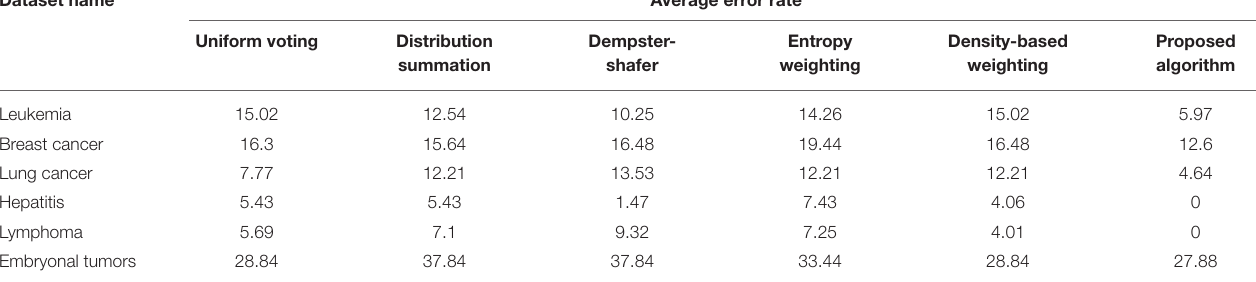
TABLE 2 | Performance on the UCI data sets (in